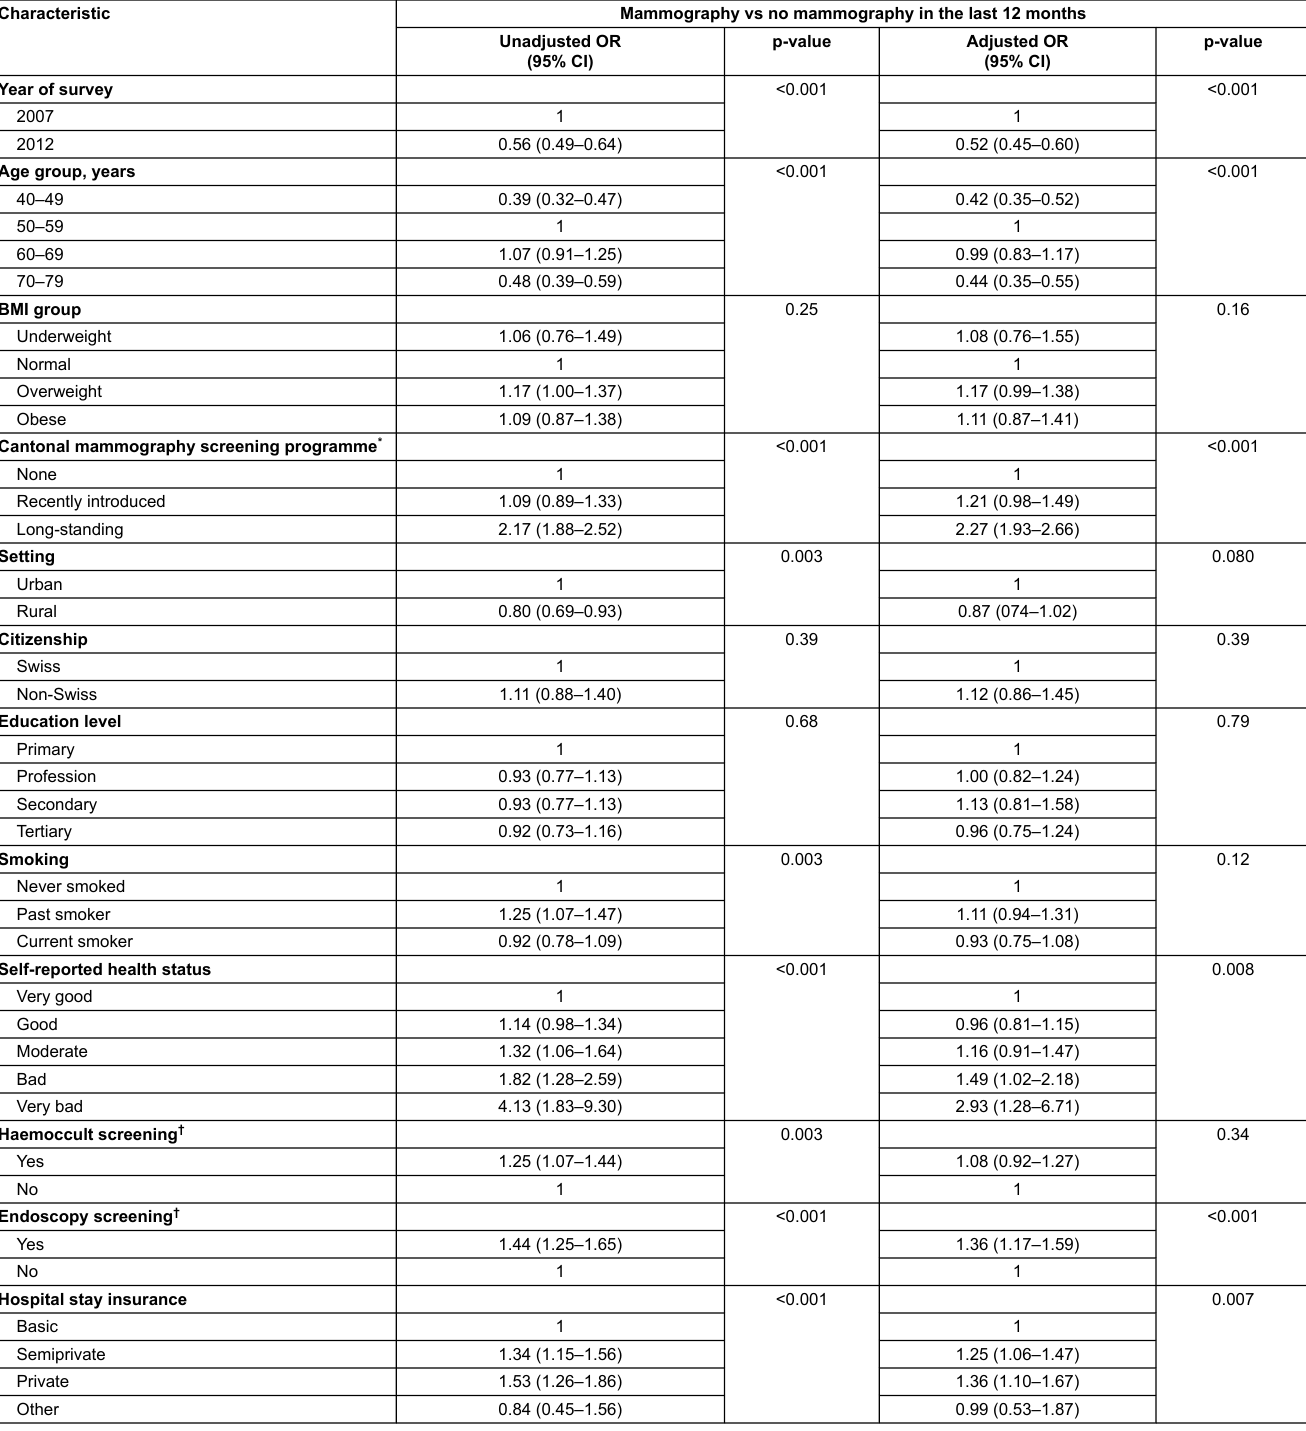
Table 2: Associations of having undergone mammography in the last 12 months with sociodemographic characteristics and health-related factors (as compared with no mam- mography performed) in women aged 40 to 79 years in Switzerland, 2007 and 2012. Mammography vs no mammography in the last 12